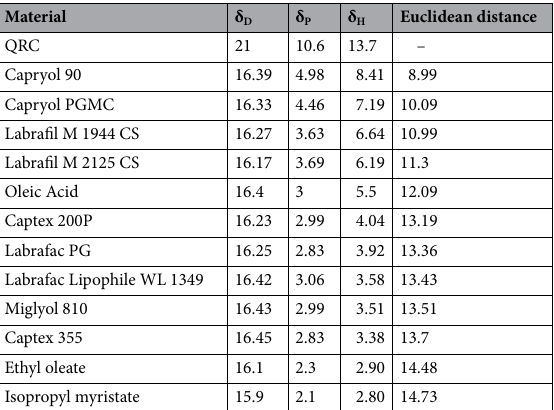
Table 2. HSP of QRC and different liquid lipids as well as the Euclidean distance between QRC and each liquid lipid.